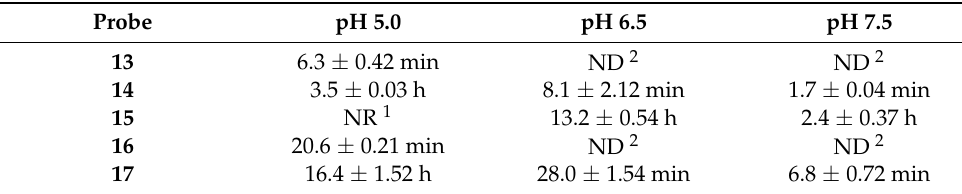
Table 1. Half-lives of probes 13 – 17 at different pH